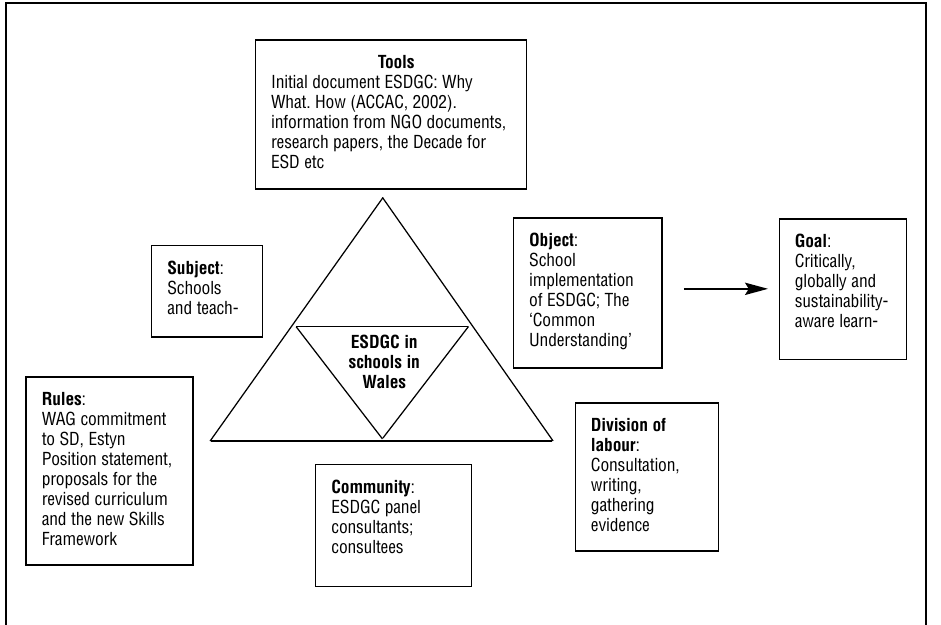
Figure 2:The later stages of the WAG ESDGC panel represented by Activity Theory